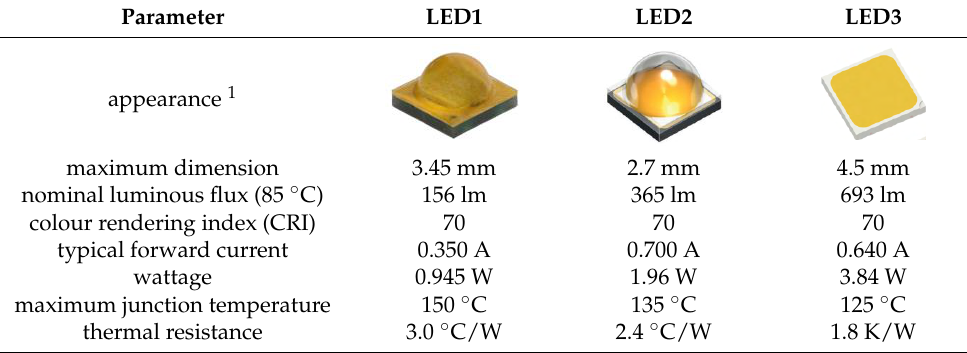
Table 2. The summary of technical parameters selected for presentation of high-power LEDs. Parameter